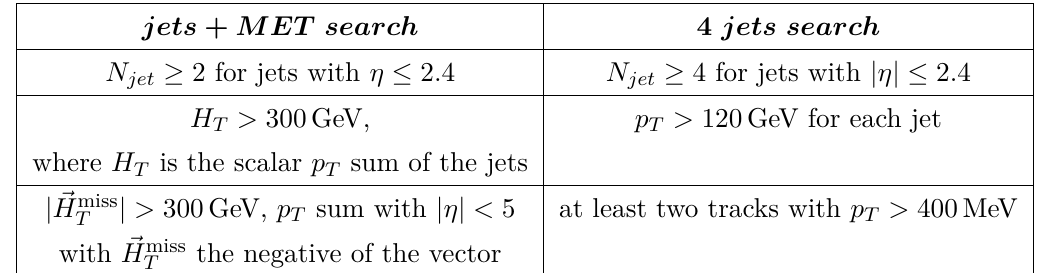
Figure 3. Radial distribution of the dark pion decay lengths in the laboratory frame, for various values of cτ π , m X = 1200 GeV and m π = 2 GeV. The black lines indicate the typical extent of D D the LHC detectors, i.e. where displaced decay signatures can in principle be detected, while earlier (later) decays will appear as prompt (missing energy) signatures.